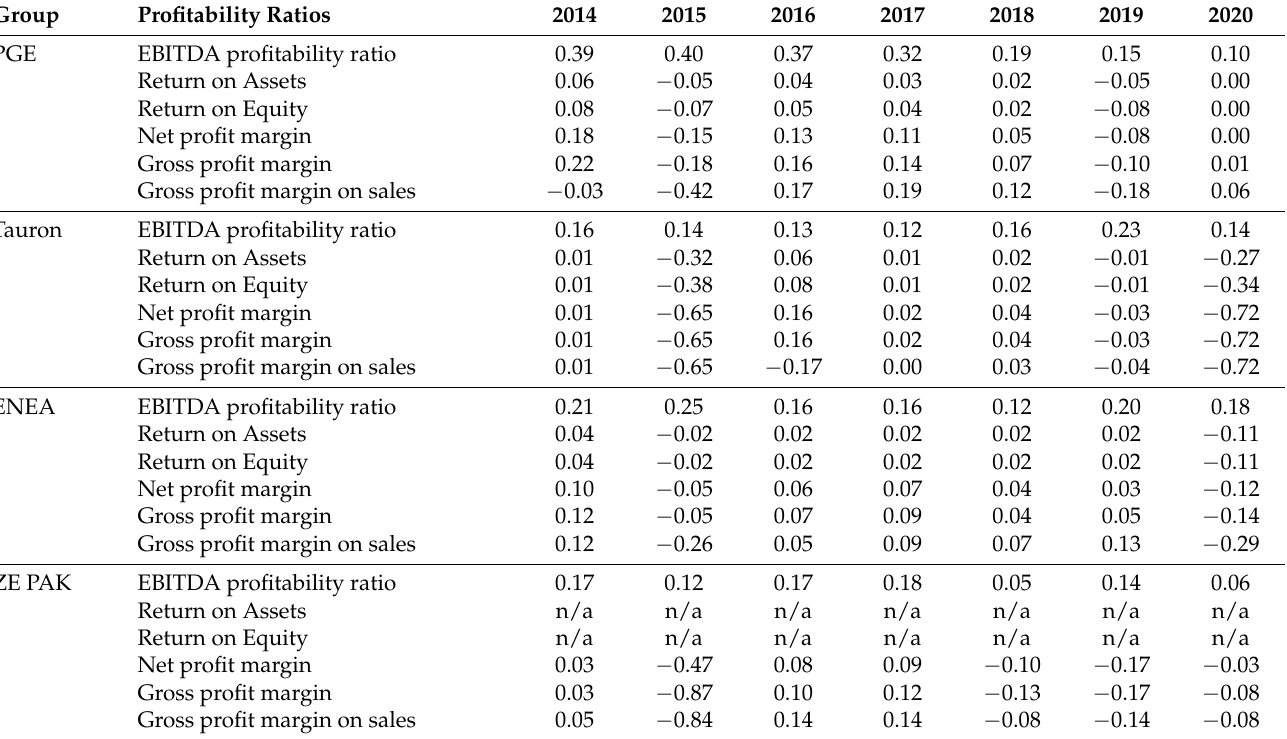
Figure 2. Profitability ratios of capital groups in the years 2014–2020 (Own study). Profitability ratios achieved by the Generation segment are presented in Figure 2 and Table 19. The highest average EBITDA ratio is PGE (26%), followed by ENEA, Tauron, and ZE PAK (18, 15, and 13%). The assets of the PGE group have the highest capacity to generate profits, followed by the ENEA and Tauron groups. Table 19. Profitability indicators of the production segment in the researched